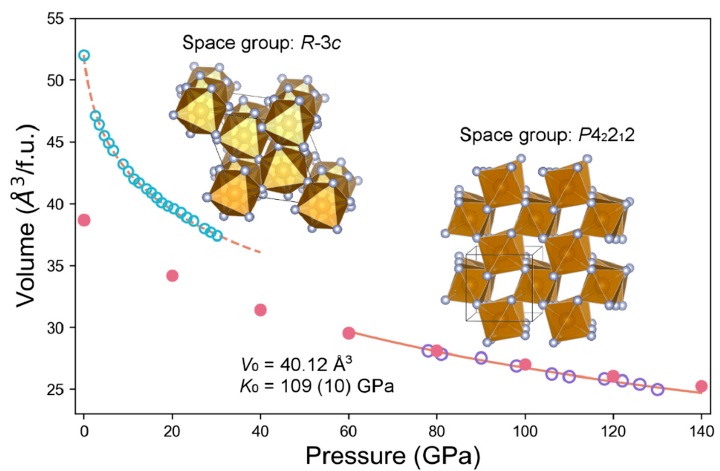
Figure 3. Measured FeF 3 unit cell volumes at high pressure and 300 K. Open purple circles from this study show pressures based on the Au pressure calibration (the error bar of ±2 GPa). The solid curve at relatively high pressures from 78 to 130 GPa shows the equation of state for FeF 3 with a tetragonal unit-cell structure. Solid red circles are calculated by first-principles simulation. The equation of state of high-pressure tetragonal FeF 3 is compared with the low-pressure trigonal phase [18].